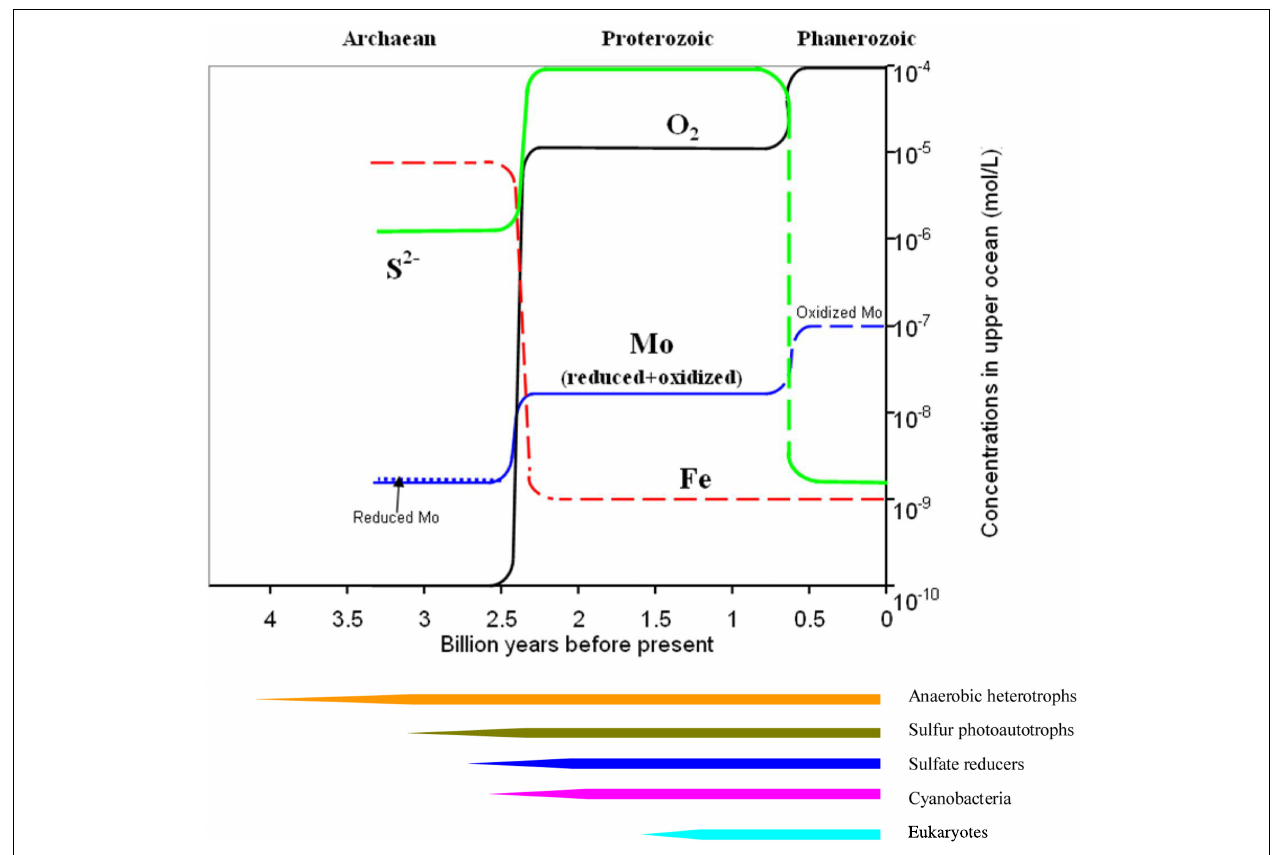
FIGURE 2 | Evolution of the Mo redox dynamics along with key elements of O, S, and Fe in the ocean over the Earth’s history. Evolutionary sequence of major life forms is shown at the lower panel. Note: the detailed and complex evolution of both chemical composition and life forms are smoothed out for